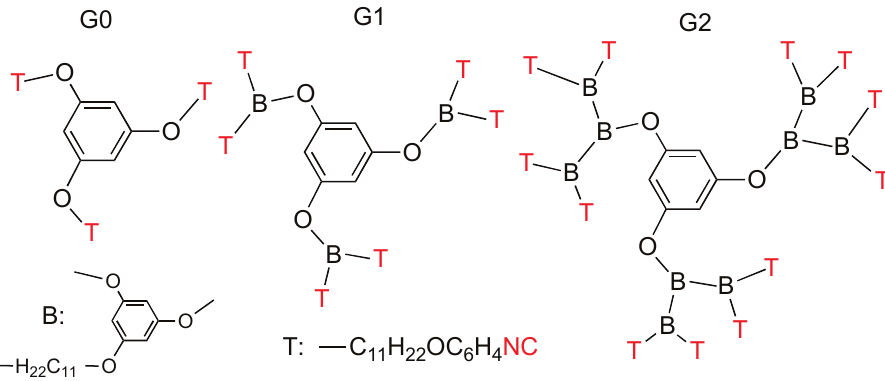
Figure 12. Polyisocyanides G0, G1 and G2 containing 3, 6, and 12 terminal isocyanide